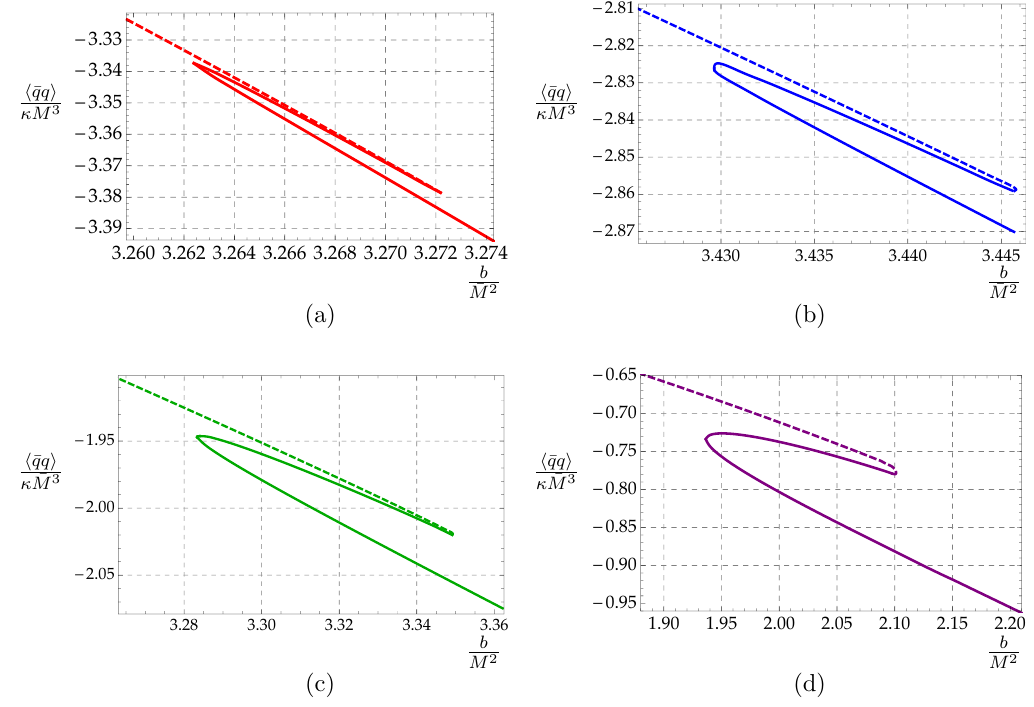
Figure 6 . Zoom into the transition region between Minkowski and black hole embeddings for the quark condensate. The values of the temperature are T= (cid:22) M = 0.55 (a), 0.59 (b), 0.65 (c), and 0.734 (d). The dashed lines represent Minkowski embeddings, whereas the solid lines represent black hole embedding.